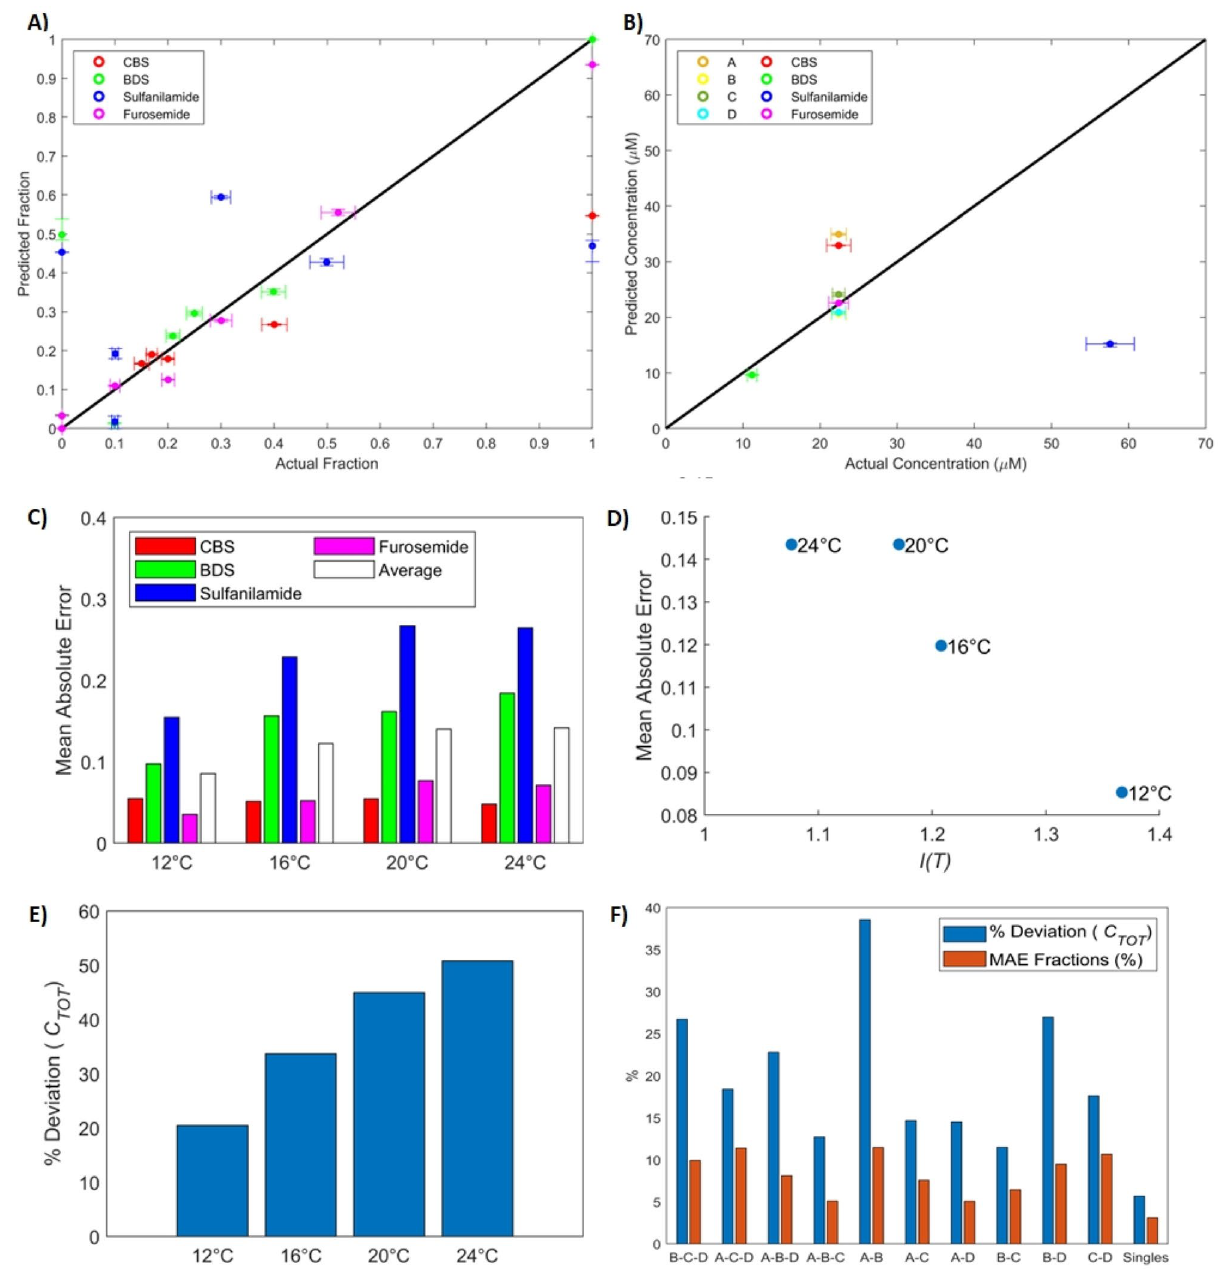
Figure 9. Performance of the composition and concentration estimation algorithm. ( A ) Calculated fractions with respect to actual fractions of the four analytes in each of the 8 mixtures detailed in Table 1. These fractions were estimated from sensorgrams at 12 °C only with kinetic parameters identified from data set (B–C–D). (B) Calculated concentration with respect to actual concentration for each of the 8 mixtures. These were estimated along the fractions using sensorgrams at 12 °C only with kinetic parameters identified from data set (B–C–D). ( C ) Mean absolute error of estimated fractions for each analyte at each temperature. The composition estimation algorithm was used independently for each set of kinetic parameters corresponding to each data set (all combinations of 2 and 3 mixtures) and each temperature, and mean absolute errors were averaged across all data sets and mixtures. ( D ) Mean absolute error (averaged across all data sets) with respect to the performance indicator. Annotations on the graph indicate the corresponding temperature. ( E ) Deviation (in %) between estimated concentrations and actual concentrations (averaged across all data sets) with respect to temperature. ( F ) Deviation of the concentration and mean absolute error of the fractions with respect to the data set that was used to identify the kinetics. Those were taken at 12 °C only. In this figure, ‘singles’ refers to single-analyte